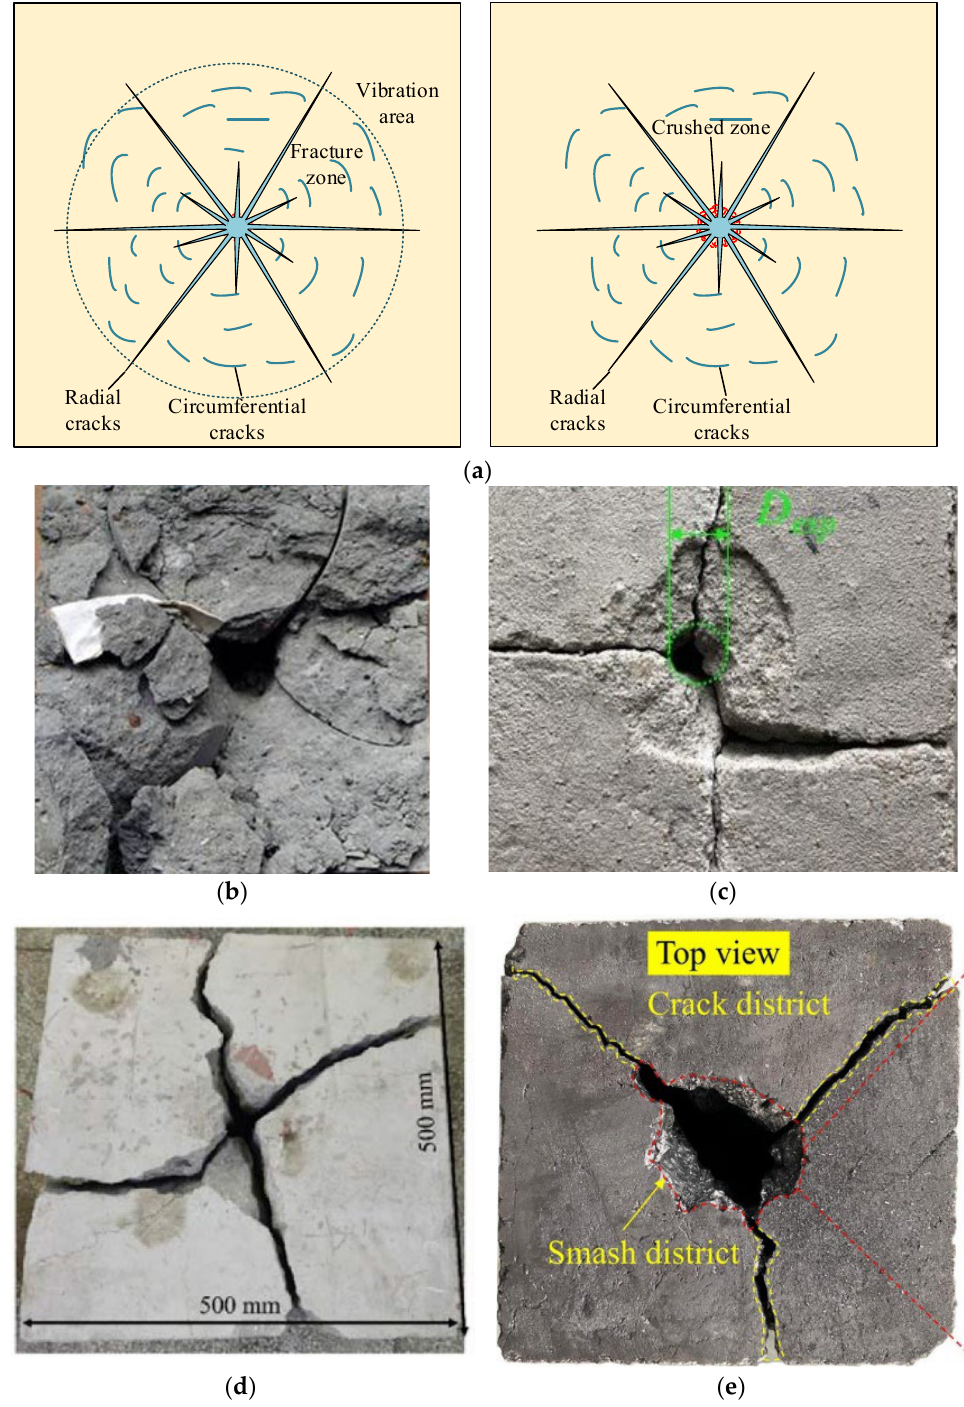
Figure 13. Overall characteristics of CDPTB cracks. ( a ) Schematic diagram of CDPTB fracture characteristics; ( b ) Experimental result from Bai [34]; ( c ) Experimental result from Shang et al. [35]; ( d ) Experimental result from Yang et al. [36]; ( e ) Experimental result from Shang et al.[37].